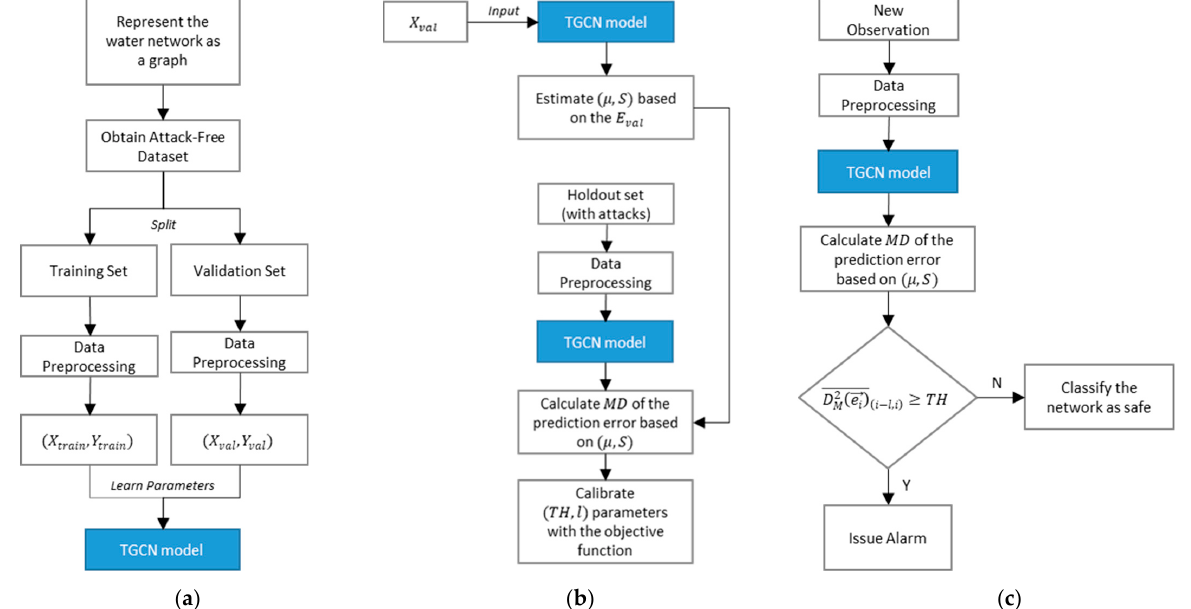
Figure 3. Methodology outline: ( a ) Developing the TGCN model to predict current SCADA observations, ( b ) calibration of the attack detection scheme, ( c ) application process of the attack detection algorithm to new observations.